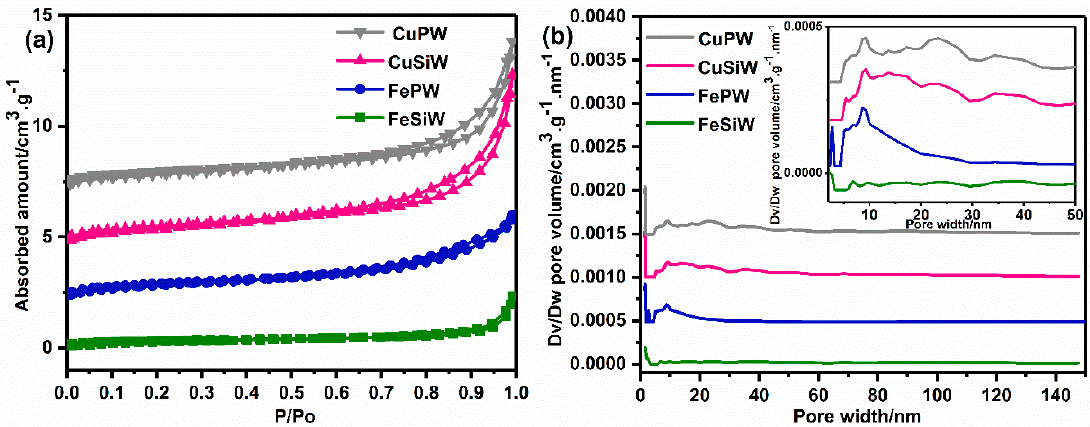
Figure 3. ( a ) N 2 adsorption/desorption isotherms and ( b ) DFT pore size distribution curves of the as-synthesized heteropolyacid salt samples.